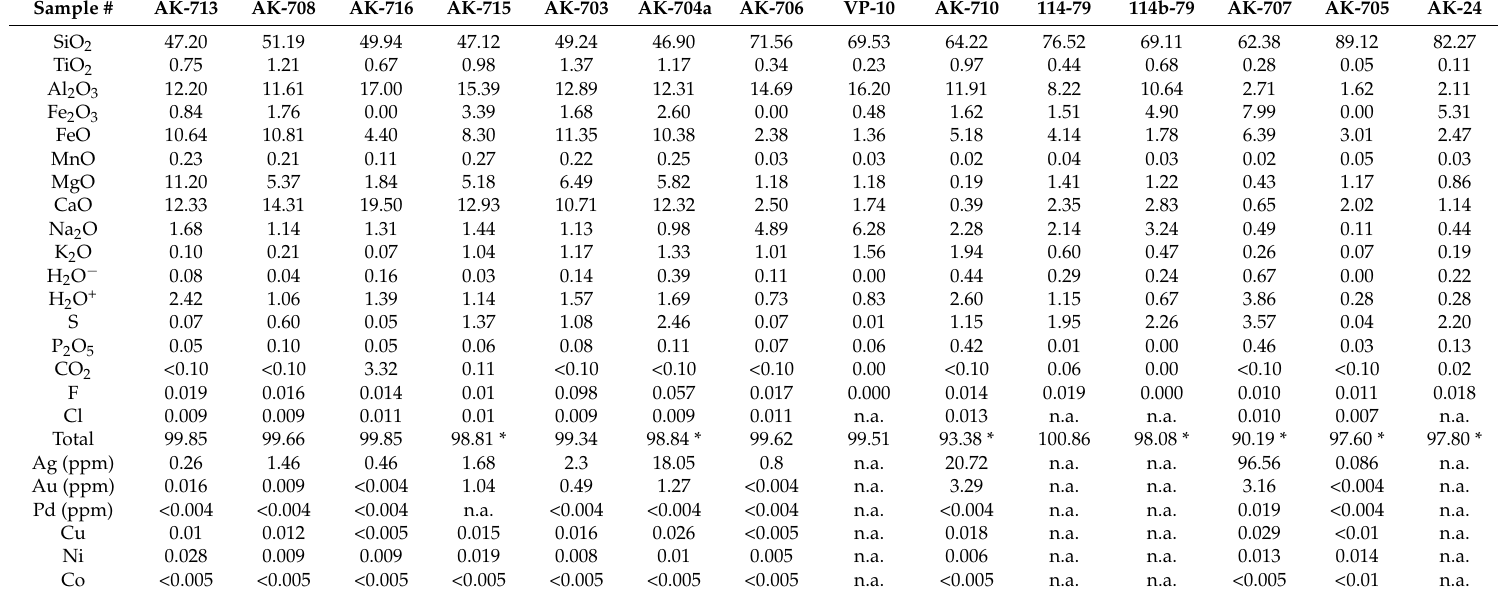
Table 1. Chemical composition of the mineralized rocks of the Oleninskoe deposit,